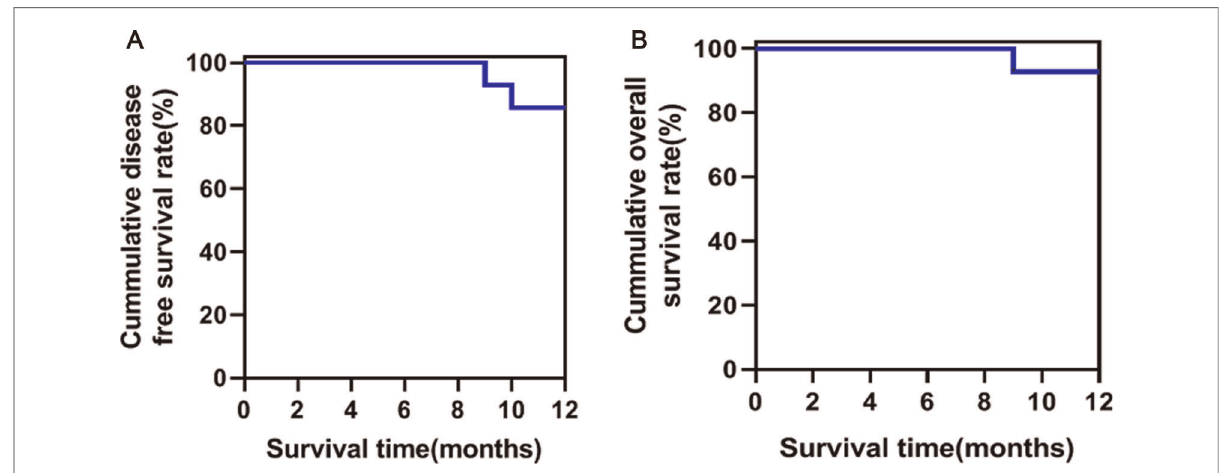
FIGURE 2 Survival curve of patients with laparoscopic pancreatoduodenectomy (LPD) combined with major venous resection to reconstruction. ( A ) Disease- free survival curve; ( B) . overall survival